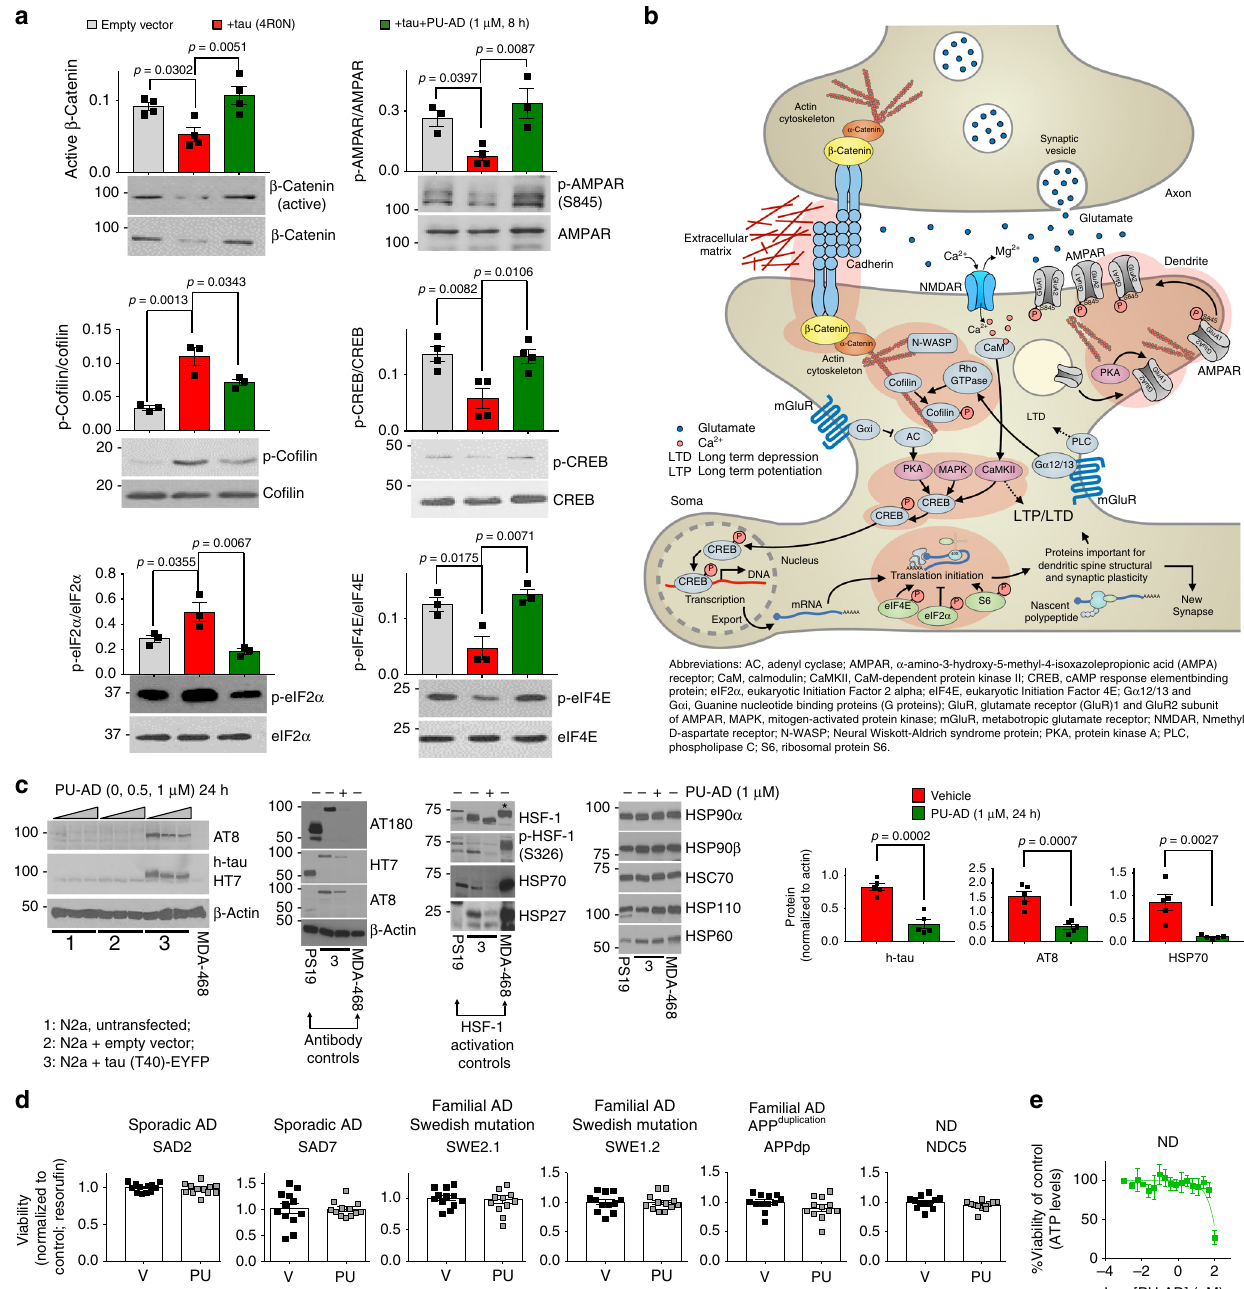
Fig. 6 PU-AD de-connects epichaperome networks and reverts tau ’ s negative effect on protein pathways important for synaptic fi tness. a Western blot shows that PU-AD treatment rebalances the activity of synaptic protein pathways altered by tau overexpression in N2a cells. Graph, mean ± SEM, one- way ANOVA, Dunnett ’ s post hoc, n = 3 – 4 independent experiments. b Schematic summary of synaptic pathways altered in both AD and N2a-tau cells through epichaperome network formation. Functional effectors of protein pathways chosen for validation in ( a ) are highlighted with a red outline. See also Fig. 5. c Western blot analyses show no HSF-1 activation under conditions where both tau and phosphorylated tau levels decrease upon PU-AD treatment. MDA-MB-468 cancer cell lysates were used as a control for the presence of active HSF-1 (indicated with an asterisk). Levels of the inducible heat shock proteins HSP70 and HSP27, surrogate markers of HSF-1 activation, were also probed. The expression level of individual chaperome members (HSP90s, HSC70, HSC60, HSP110) are also shown. Graph, mean ± SEM, unpaired two-tailed t -test, n = 3. d , e Viability of iPSC-derived neurons cultured for 24 h with Vehicle (V) or PU (0.5 µ M PU-AD) ( d ) or for 72 h with concentrations of PU-AD from 0 to 100 µ M ( e ). Graph, mean ± SEM, n = 12 for ( d ) and n = 4 for ( e ). * P < 0.05, ** P < 0.01, *** P < 0.001. Source data are provided as a Source Data fi